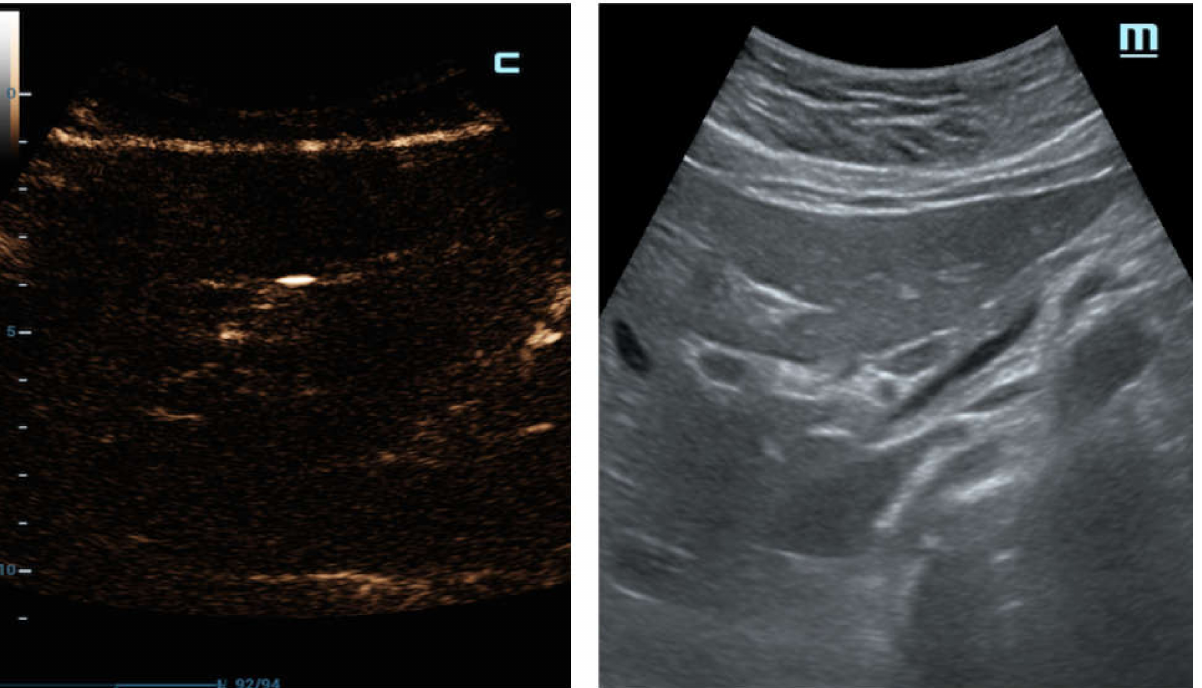
Figure 7. Female patient, 51 years old with history of radiotherapy and chemotherapy for pancreas neoplasm. Surgery revealed micro-perforation in the first tract of duodenum related to post-actinic damage in correspondence to the duodenum wall. Longitudinal US C-mode scan of the liver correctly detects the few air bubbles displayed as bright luminescent echo lines; this finding is clearly observed on the C-mode; as shown, it is very difficult to find clear corresponding data with